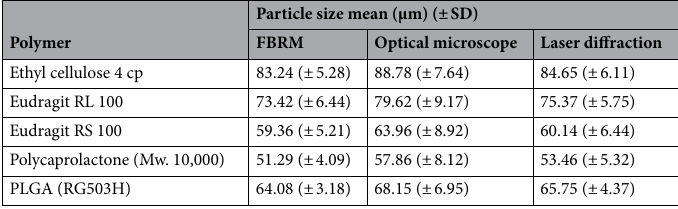
Table 1. Effect of polymer type on particle size mean of